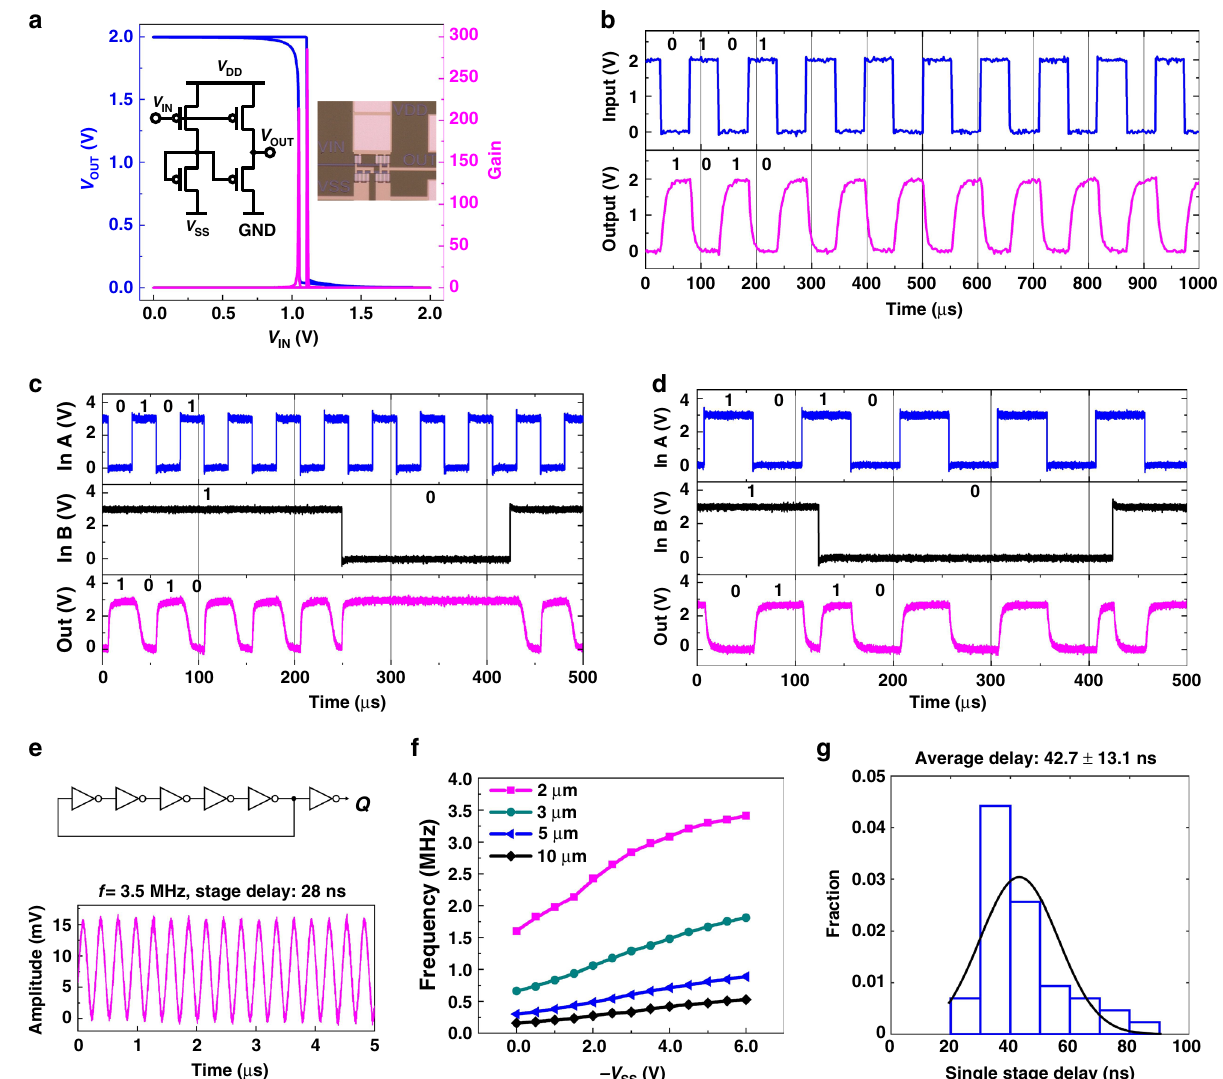
Fig. 3 Flexible pseudo-CMOS combinational logic gates and ring oscillators. a Circuit diagram of using depletion-mode TFTs, die photo, input – output characteristics and small signal gain of a pseudo-CMOS inverter. Channel length ( L ) = 10 μ m, V DD = 2 V, V SS = − 3 V. b Measured waveforms of a pseudo- CMOS inverter running at 10 kHz. L = 10 μ m, V DD = 2 V, V SS = − 3 V. c Measured waveforms of a pseudo-CMOS NAND gate running at 20 kHz. L = 10 μ m, = 3 V, V = − 3 V. d Measured waveforms of a pseudo-CMOS XOR gate running at 10 kHz. L = 10 μ m, V V DD SS output characteristics of a fi ve-stage ring oscillator. The ring oscillator shows an oscillation frequency of 3.5 MHz with a stage delay of 28 ns. L = 2 μ m, V = 3 V, V = − 3 V. f Frequency responses of the fi ve-stage ring oscillators under various V DD SS g Stage delay statistics of a total of 44 fi ve-stage ring oscillators with V DD = 3 V, V SS = − 3 V. The fi ve-stage ring oscillators show average stage delays of 42.7 ± 13.1 ns, comparable to current state-of-the-art CMOS-type CNT circuits 7 . Note : Results of 2 µ m ring oscillators in e and f are from different devices and they are slightly different in performance due to process variations as shown in g . For measurement data in e , due to a large loading effect (measured to be ~125 pF), the measured waveform only has ~10 mV scale, which is also consistent with our simulation results in Supplementary Fig.